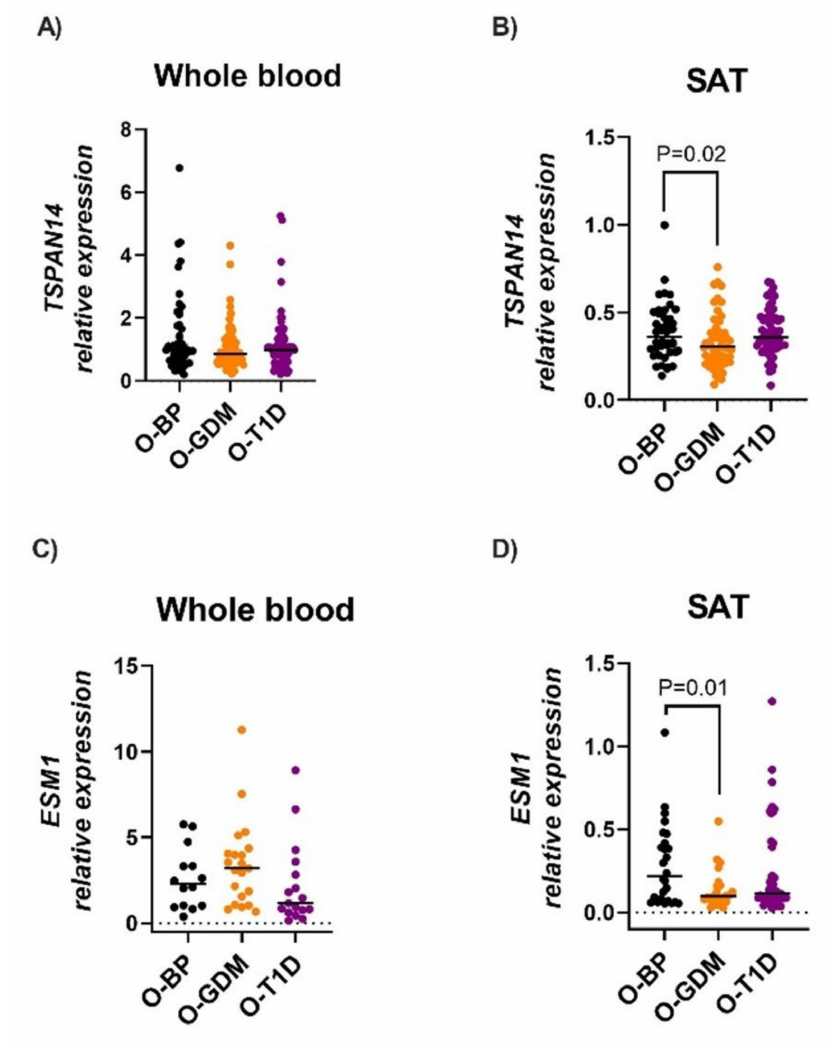
Figure 5. TSPAN14 ( A , B ) and ESM1 ( C , D ) expression in whole blood and subcutaneous adipose tissue (SAT). Bars represent medians. p -values represent difference between offspring groups, and were calculated by multivariate regression modelling, including the covariates of maternal diabetes status, maternal pre-pregnancy BMI, and offspring sex. O-GDM: offspring of women with GDM, O-T1D: offspring of women with T1D, O-BP: offspring of women from the background